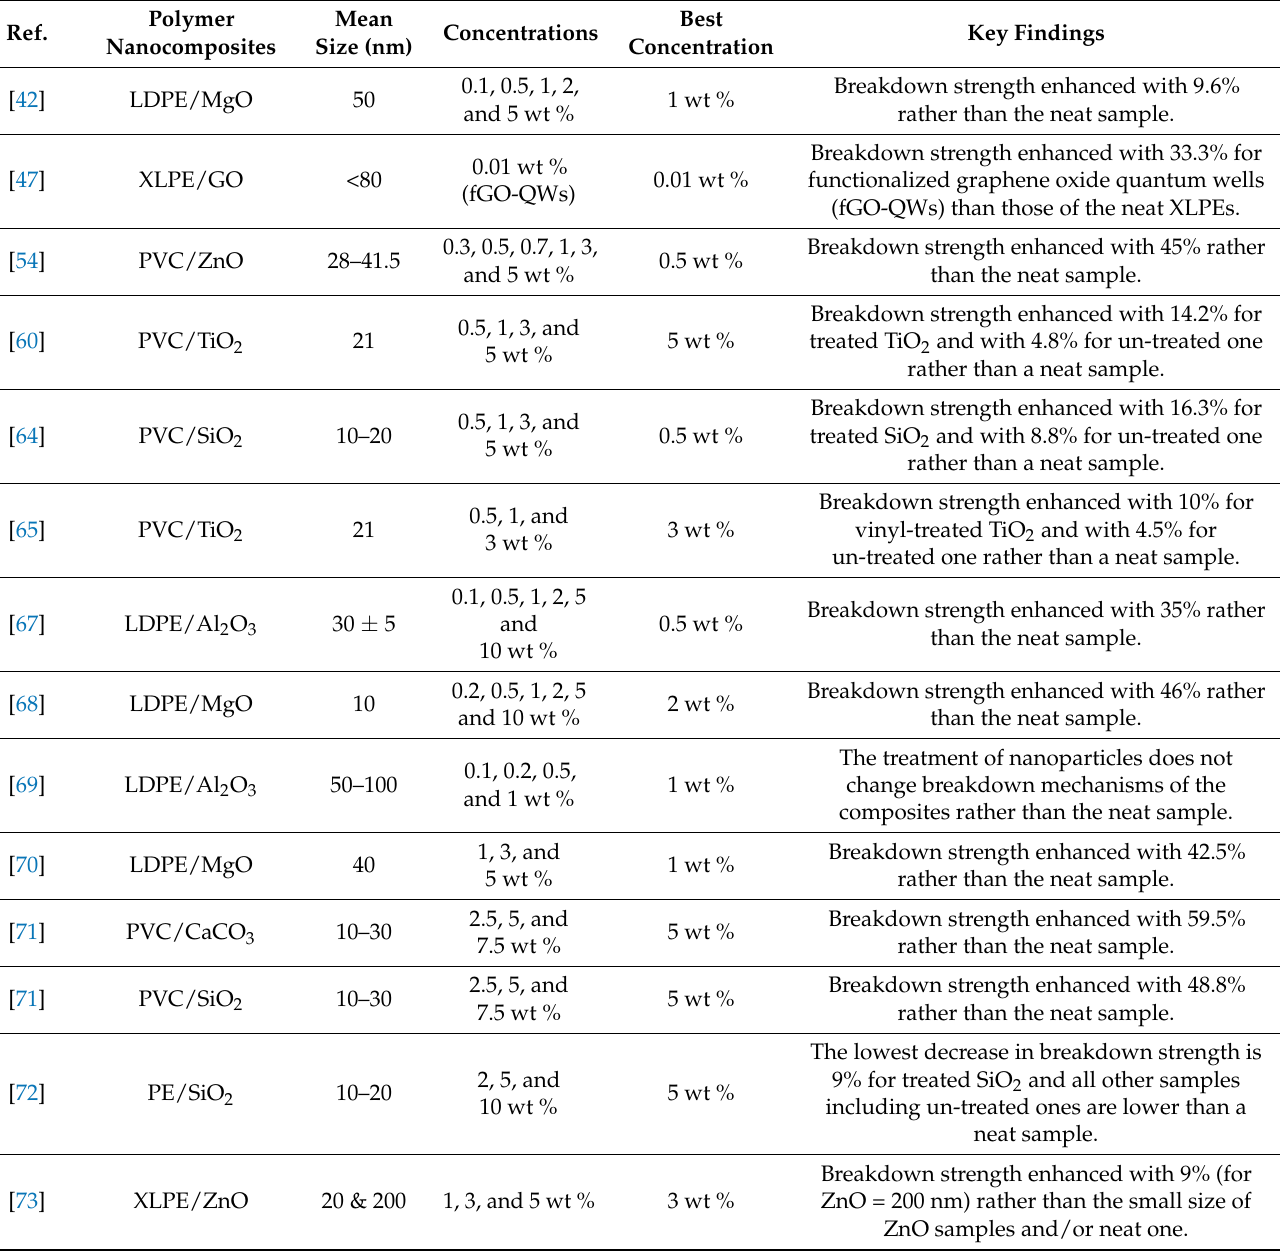
Table 2. DC breakdown strength of polymer nanocomposites based on PE and PVC.